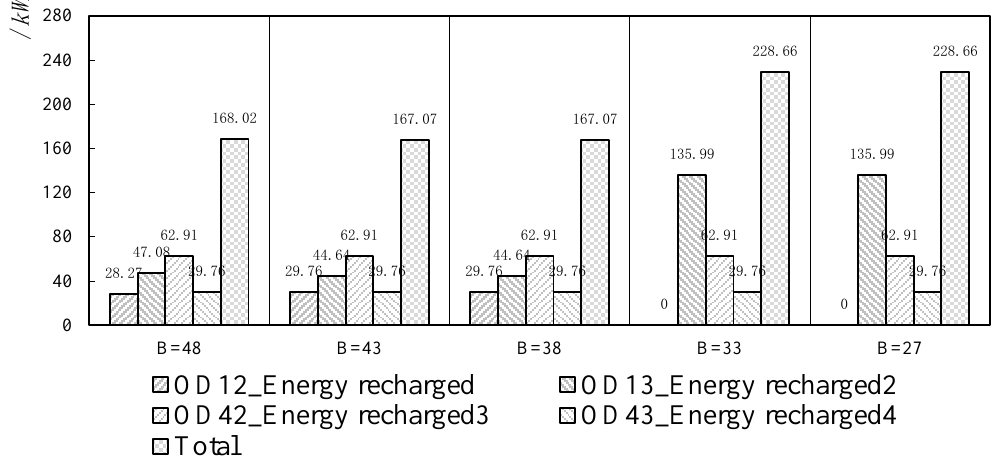
Figure 10. Comparison of the energy recharged for various total cost budgets.